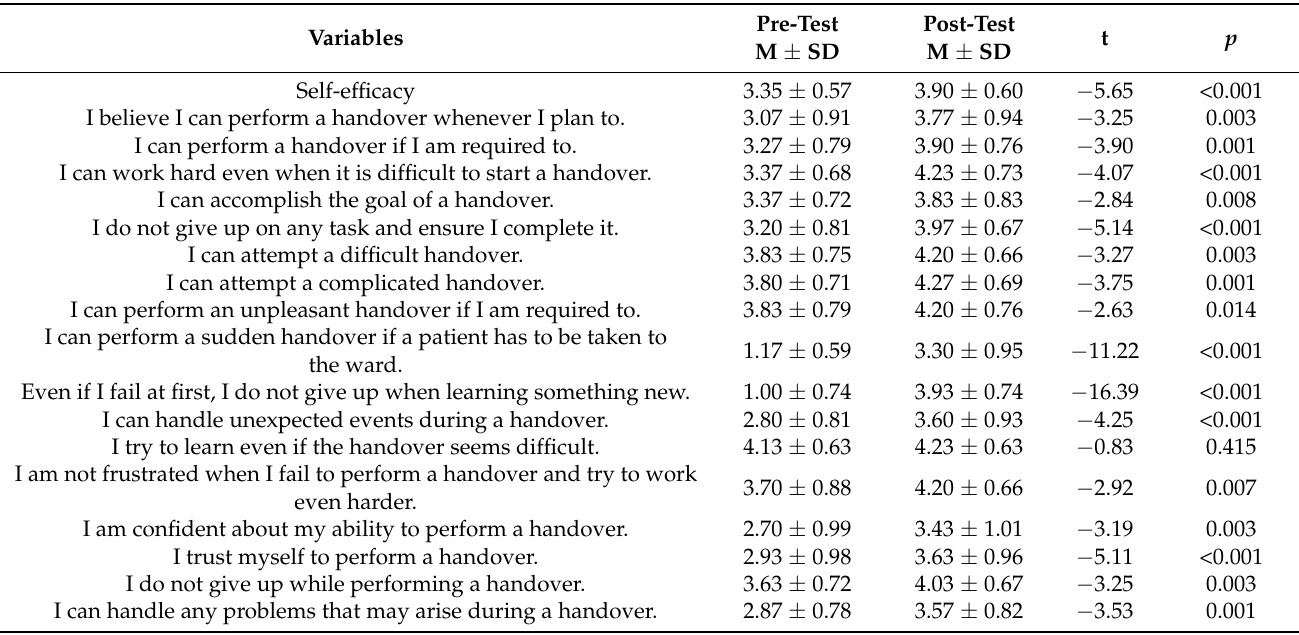
Table 2. Comparison of self-efficacy before and after the education program ( N = 30).